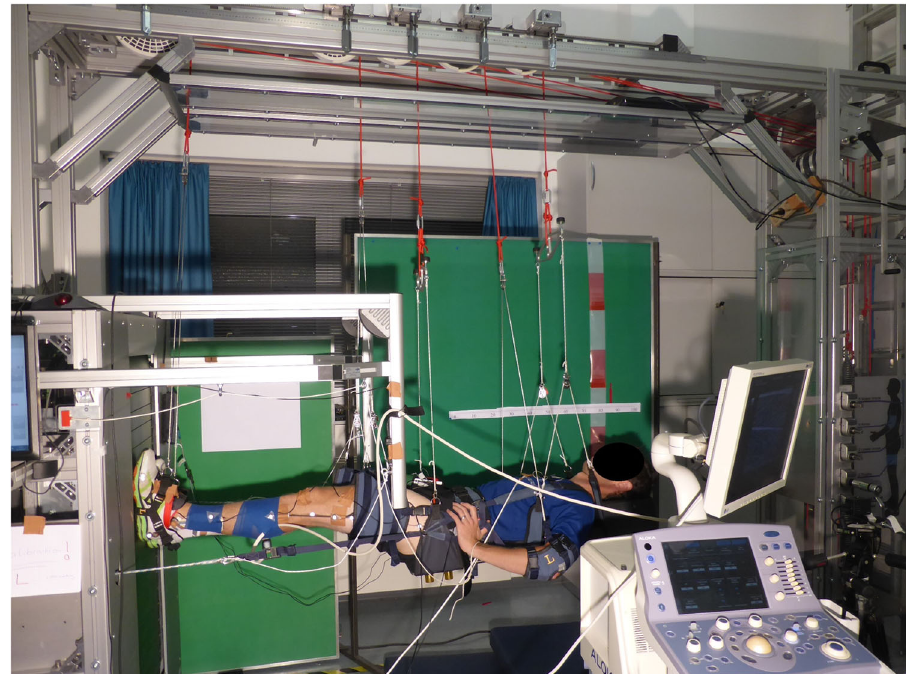
Fig. 3 VTF experimental set-up. Participant being suspended horizontally on the vertical treadmill facility (VTF) with an ultrasound transducer attached to the mid-belly of the GM muscle and electrogoniometers to record knee and ankle joint angles. Photo credit Charlotte Richter; participant provided written informed consent to publish this photo.